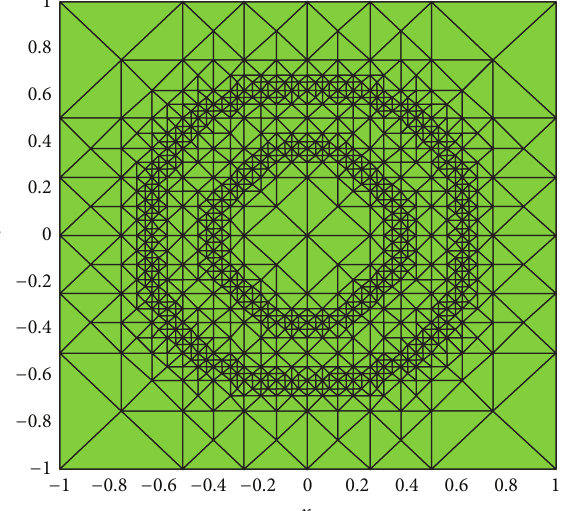
Figure 4: The mesh of the planar dam-break problem at 𝑡 = 0.2 using the adaptive method. The 𝑥 -axis is horizontal. The 𝑦 -axis is vertical.